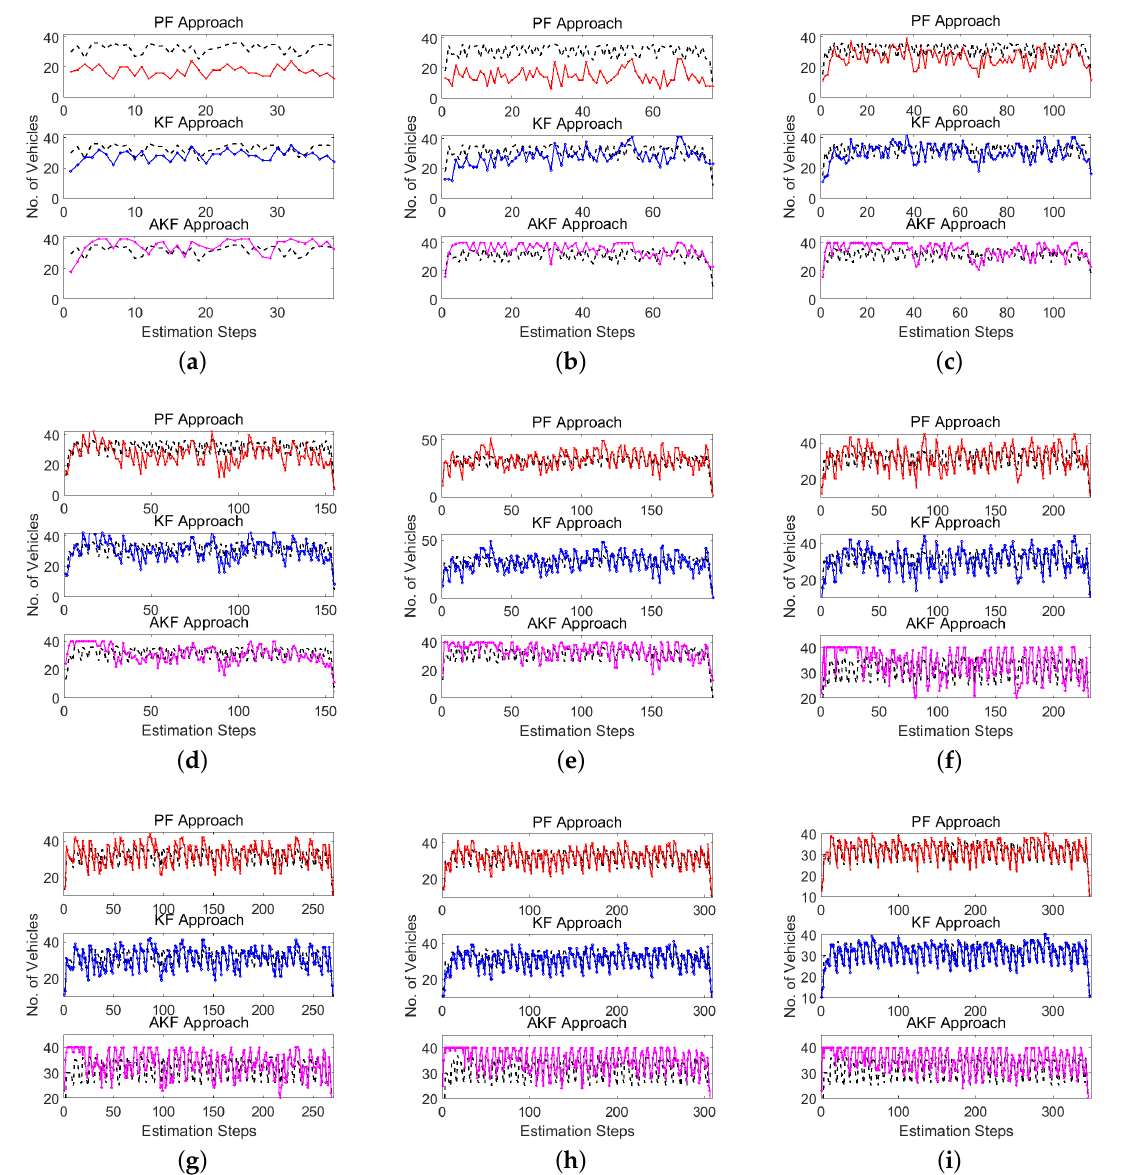
Figure 2. Actual and estimated vehicle counts at different LMP scenarios: ( a ) 10%, ( b ) 20%, ( c ) 30%, ( d ) 40%, ( e ) 50%, ( f ) 60%, ( g ) 70%, ( h ) 80% and ( i )